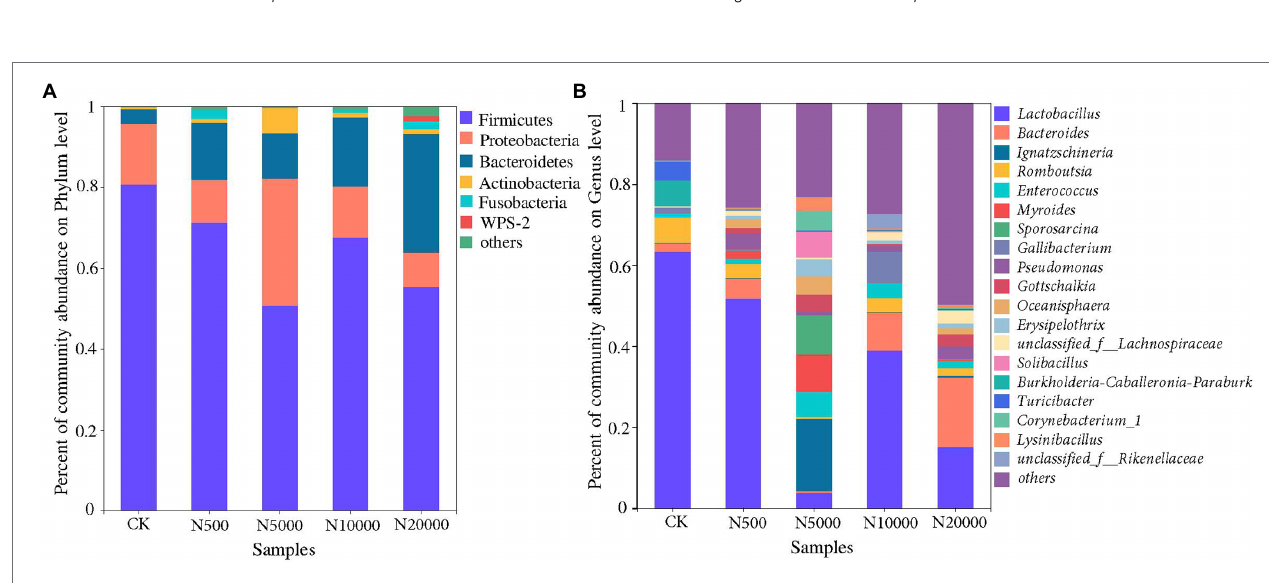
Data in the table are mean ± SD. Sample number n = 3. Different lowercase letters within rows indicate significant difference at the p < 0.05 level.